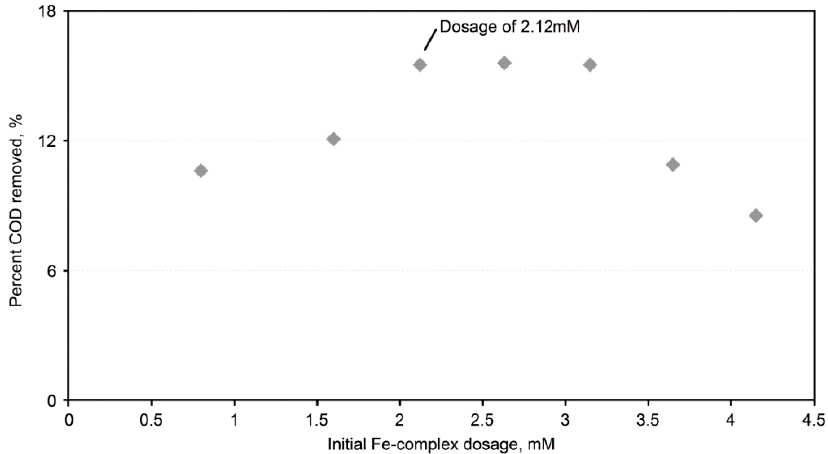
Figure 5. Plots of the percent COD removed after its regeneration at various initial Fe-complex dosages and a peroxide concentration of 2.5%. The use of an initial Fe complex at 2.12 mM had the highest percent COD removal value. A higher Fe complex could consume the oxidative capacity of the peroxide and resulted in the drop of the percent COD removal.